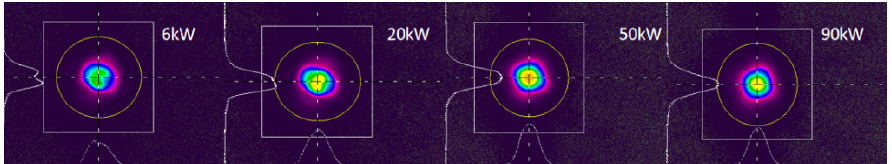
Figure 8. Evolution of the output beam distribution at 1030 nm in 10 m GRIN fiber with different pulse peak power.